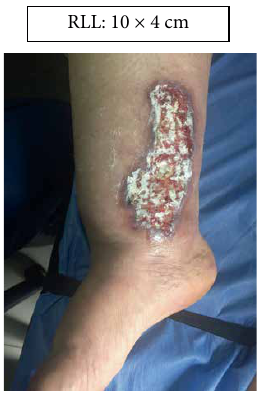
Figure 11: Start. Lower right limb.